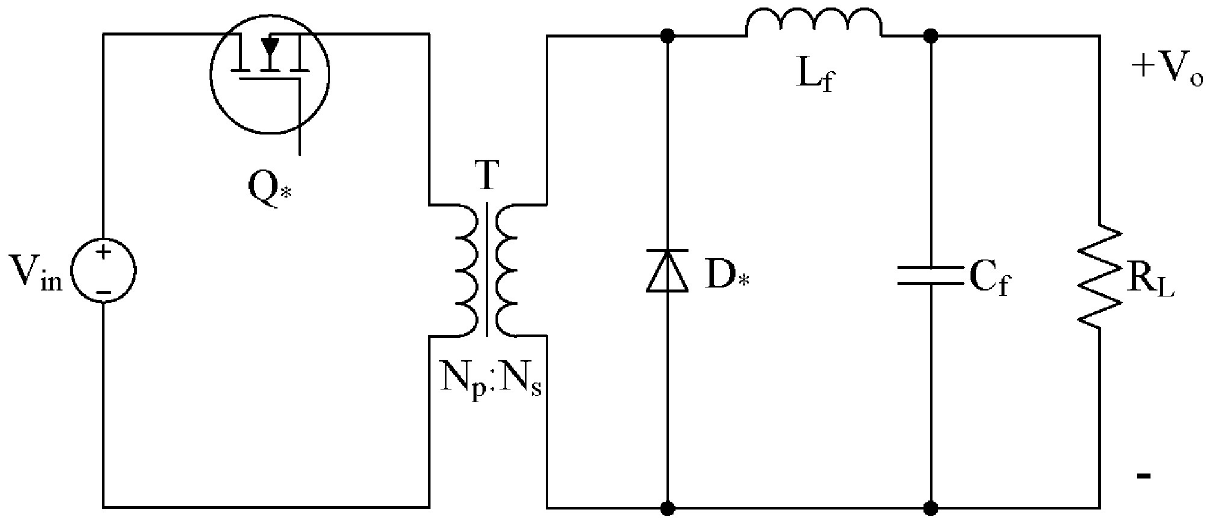
Fig 7. Buck circuit equivalent model of full-bridge